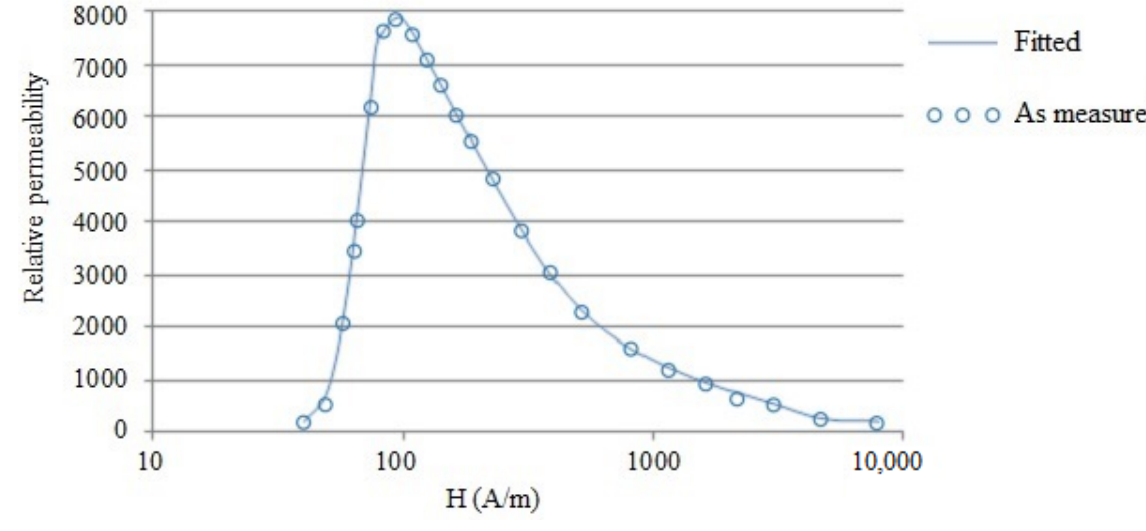
Figure 2. Variation of relative permeability with applied magnetic field.